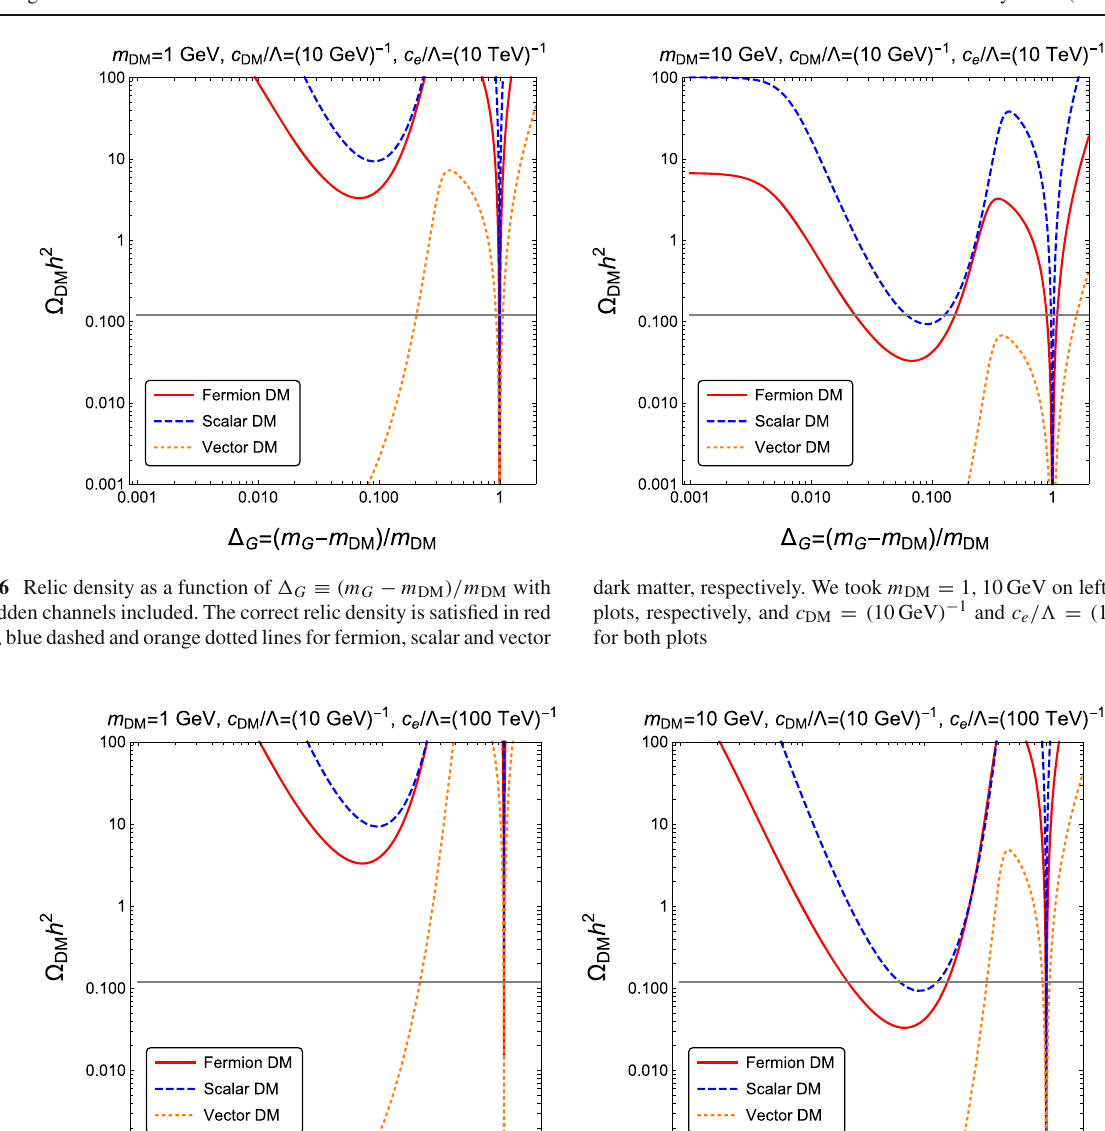
ing the counterparts for fermion or vector dark matter. The future Belle-2 results [78,79] could improve the limits or probe the larger portion of the relic density regions. We also show the ( g − 2 ) μ favored region in green and orange at 1 σ and 2 σ levels, respectively, but it is excluded by BaBar for the universal lepton couplings. 1 In the same plot, we show the gray contours for DM-electron scattering cross section with σ DM − e = 10 − 44 , 10 − 48 cm 2 , but most of the